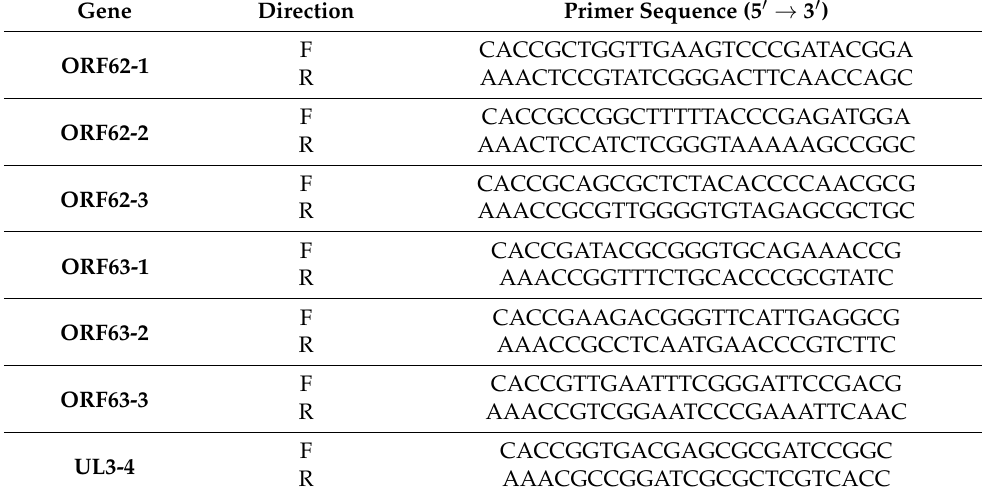
Table 1. gRNA Oligos.